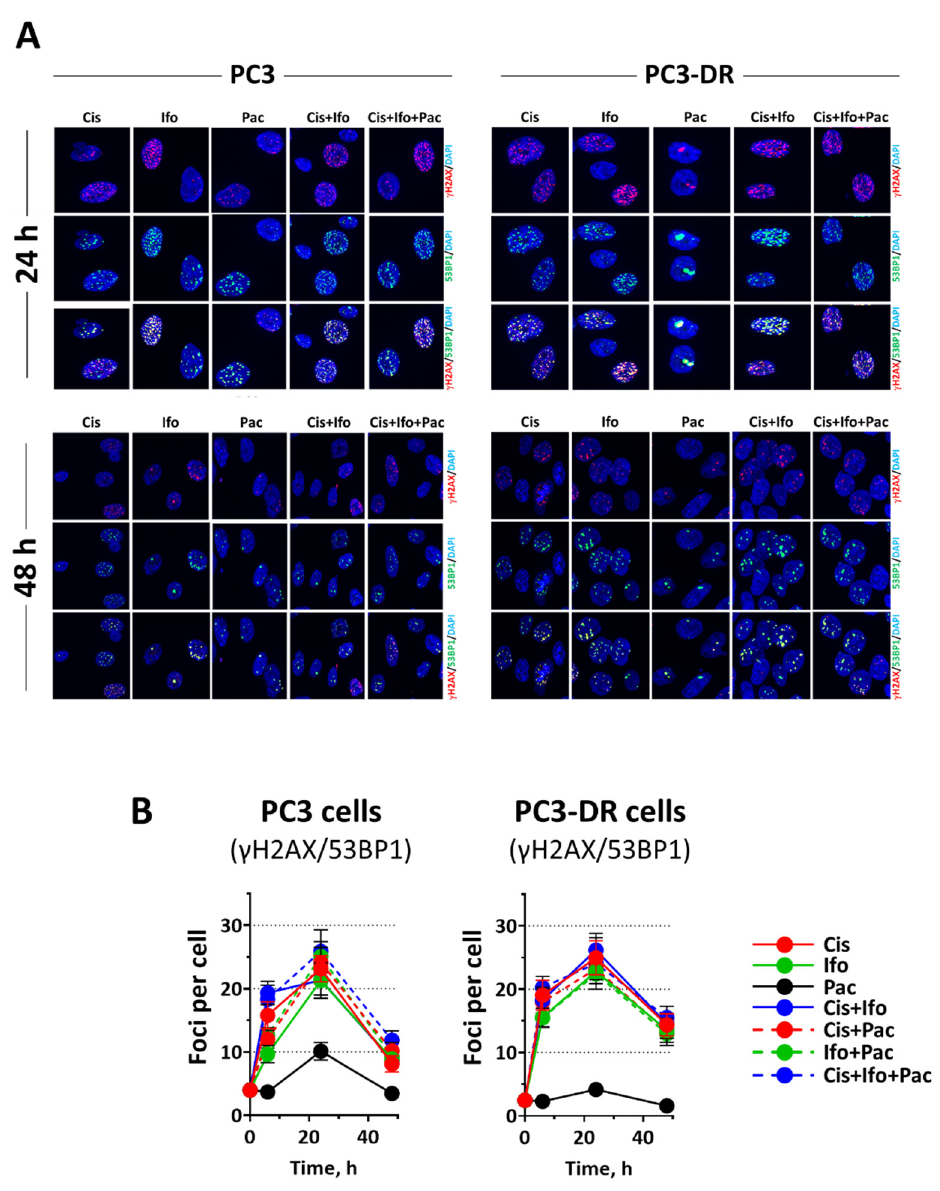
Figure 8. Evaluation of DNA double-strand breaks (DSB) in the cells following the treatment. PC3 and PC3-DR cells were treated with the individual drugs at concentrations equal to their corresponding IC 50 s and their combinations for 6 h. ( A ), 6 h, 24 h, and 48 h following the treatment, immunofluorescence double staining for γ H2AX (red) and 53BP1 (green) was performed. ( B ), Colocalized γ H2AX/53BP1 foci were considered as a marker of DSB and were quantified microscopically. For each experimental condition, at least 100 cells were analyzed. Data are indicated as means ± SD from at least three independent experiments. The original data are presented in Figure S10 and Table S14.